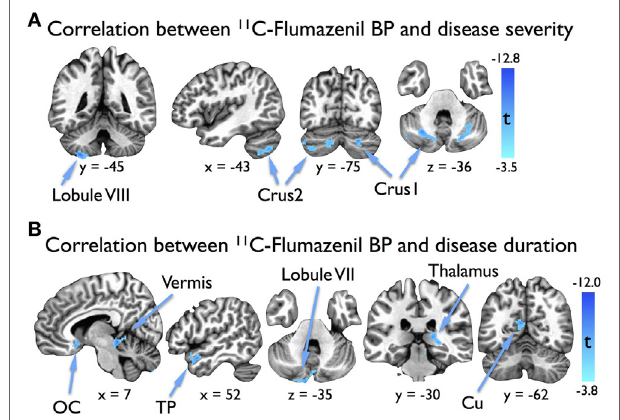
FigUre 2 | Results of voxel-based regression analyses showing (a) significant clusters in the bilateral cerebellar hemispheres where 11 C-flumazenil binding potential (BP) in cervical dystonia (CD) patients correlated with dystonia severity as measured by the Toronto Western Spasmodic Torticollis Rating Scale (TWSTRS), and (B) significant clusters where 11 C-flumazenil BP in CD patients correlated with disease duration. Significance was defined as an individual voxel statistical threshold of p < 0.005 with a cluster threshold of 100 contiguous voxels. Images are displayed such that left is anatomical left. Abbreviations: Cu, cuneus; OC, olfactory cortex; TP, temporal pole.